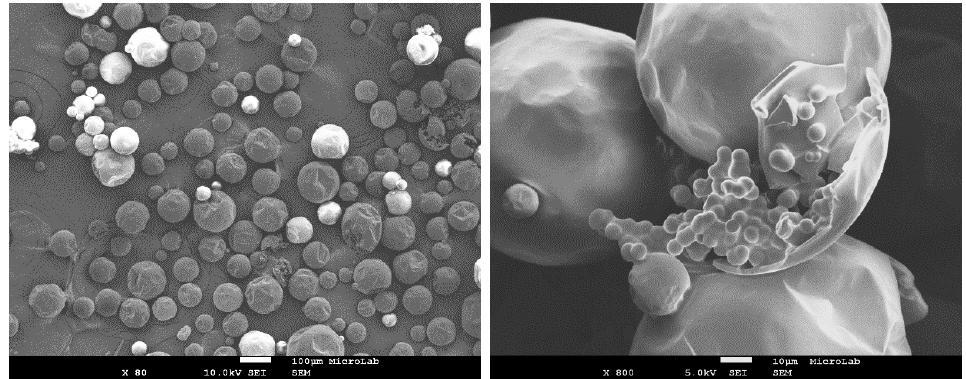
Figure 3. SEM image of D MCs (Active H source: DETA). The image on the right displays a broken MC which demonstrates the core–shell morphology typical of these MCs. Scale bar = 10 μ m.